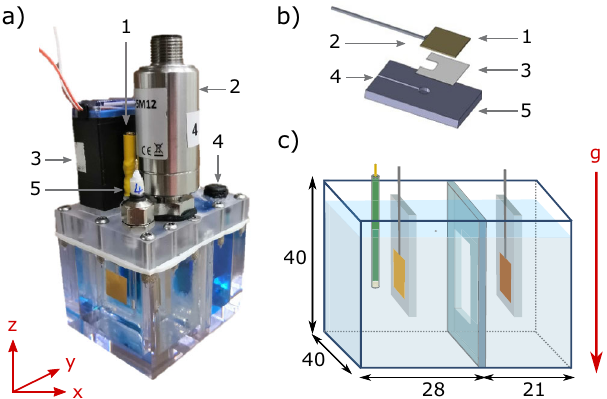
Fig. 9 Electrolysis cell design. a The polycarbonate cell showing (1) the electrode connection, (2) pressure sensor, (3) pressure release valve, (4) vent, (5) reference electrode; b Electrode preparation method showing: (1) the foil electrode, (2) soldered wire, (3) epoxy glue layer, (4) epoxy- fi lled groove for wire and solder, and (5) polycarbonate electrode holder; c the spatial arrangement of the gold anode, Ag/AgCl reference electrode (shown as green for clarity), Na fi on membrane window, and copper cathode. Numbers indicate cell dimensions (in